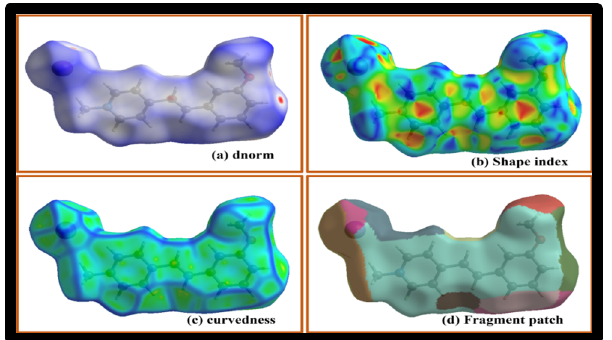
Figure 14. HS analysis of MMPI crystal mapped with ( a ) dnorm, ( b ) shape index, ( c ) curvedness, ( d ) fragment patch. ( d ) fragment